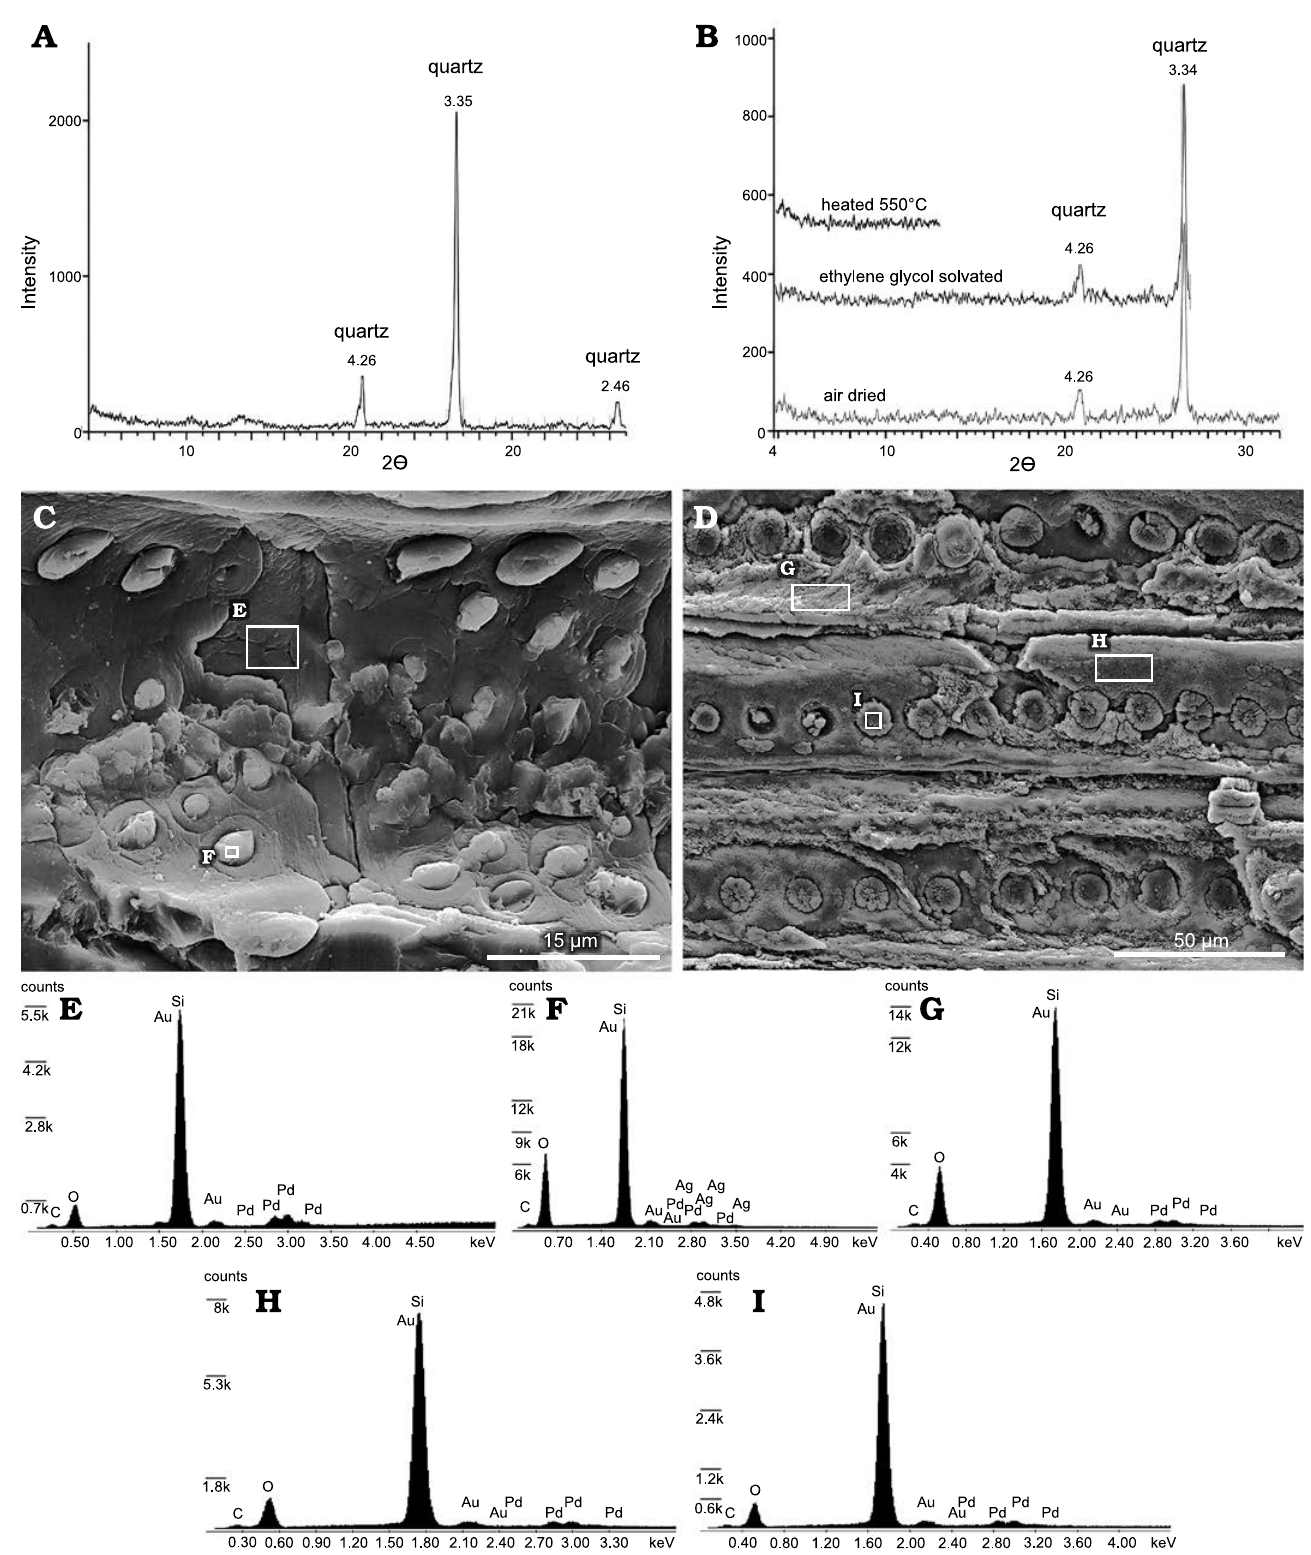
Fig. 4. XRD and SEM/EDS mineralogical and chemical analysis of Agathoxylon mendezii sp. nov. (MPM­PB­15596), Estancia El Álamo, Santa Cruz Province, Argentina, Berriasian–Valanginian. A . XRD pattern of the bulk sample showing quartz composition of the trunk. B . XRD pattern of the clay fraction showing no presence of clay minerals in the trunk. C , D . SEM of cross­field pits and tracheids in radial section. Note that quadrangular and rectangular areas correspond to the spot analysis shown in E–I. E – I . EDS patterns of xylem elements. E . Parenchyma ray cell wall. F . Inner aperture in cross­field pits. G , H . Tracheids cell walls. I. Tracheid pit cavity. All the EDS patterns are showing Si and O